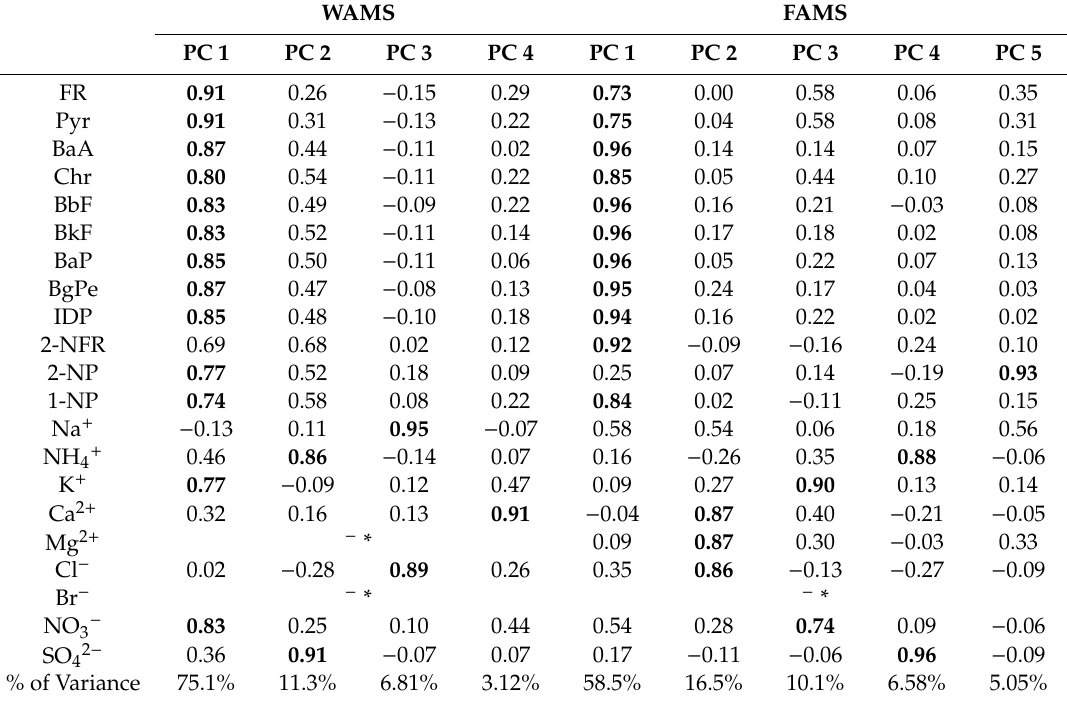
Table 1. Loading of PAHs, NPAHs, and WSIIs at WAMS and FAMS in the East Asian winter monsoon period according to principal component analysis. PC, principal